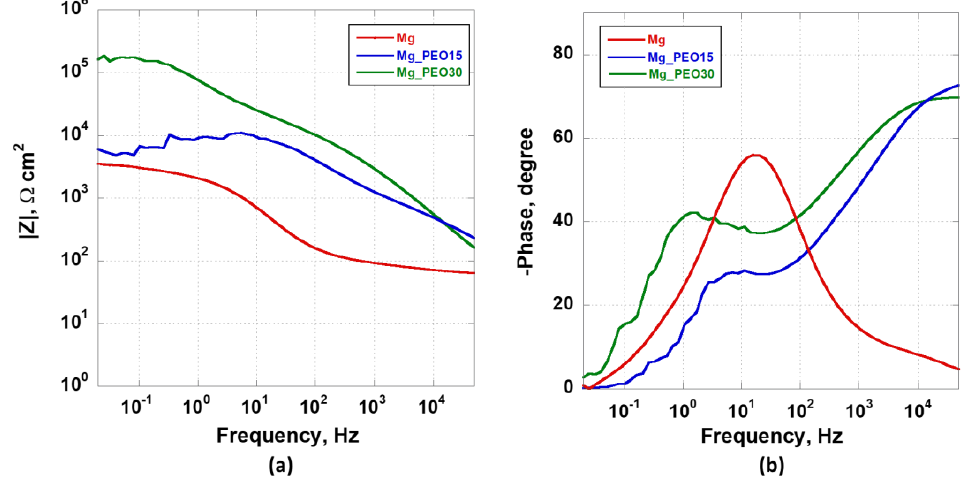
Figure 9. ( a ) Impedance modulus and ( b ) phase angle plots of samples characterized in Hank’s solution at 37 °C.